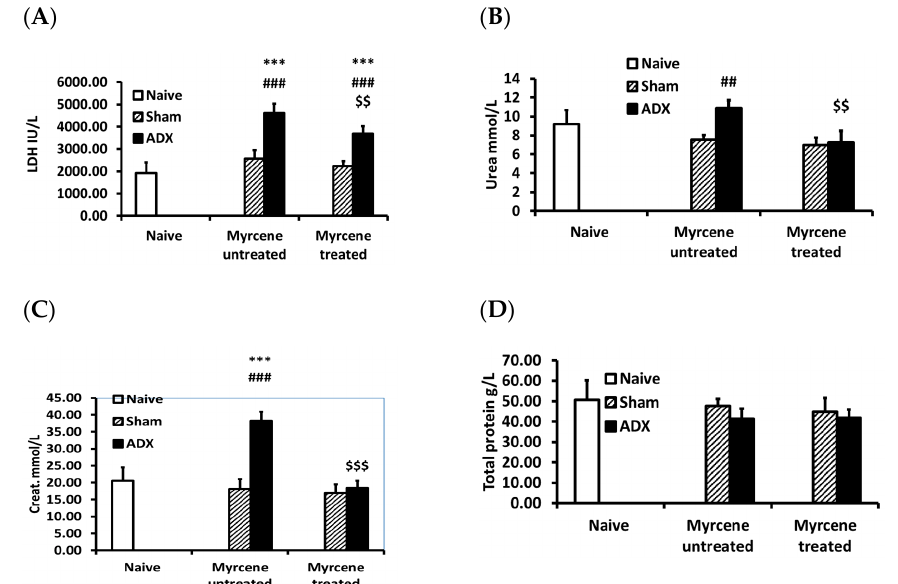
Figure 5. Serum kidney function test molecules in ADX, sham operated rats and myrcene treated ADX and sham rats: ( A ) LDH; ( B ) BUN; ( C ) creatinine; and ( D ) total protein. LDH, BUN, and creatinine were significantly increased in the untreated ADX group compared to the sham operated. Myrcene treatment significantly decreased LDH, BUN, and creatinine compared to untreated ADX group. However, treated group. Each data-point represents the mean ± STD of 6–9 rats per group. *** p < 0.001 compared to naïve; ## p < 0.01, ### p < 0.001 compared to untreated sham; $$ p < 0.01, $$$ p < 0.001 compared to untreated